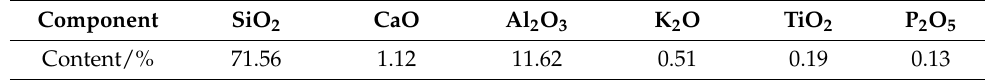
Table 1. The main chemical components of